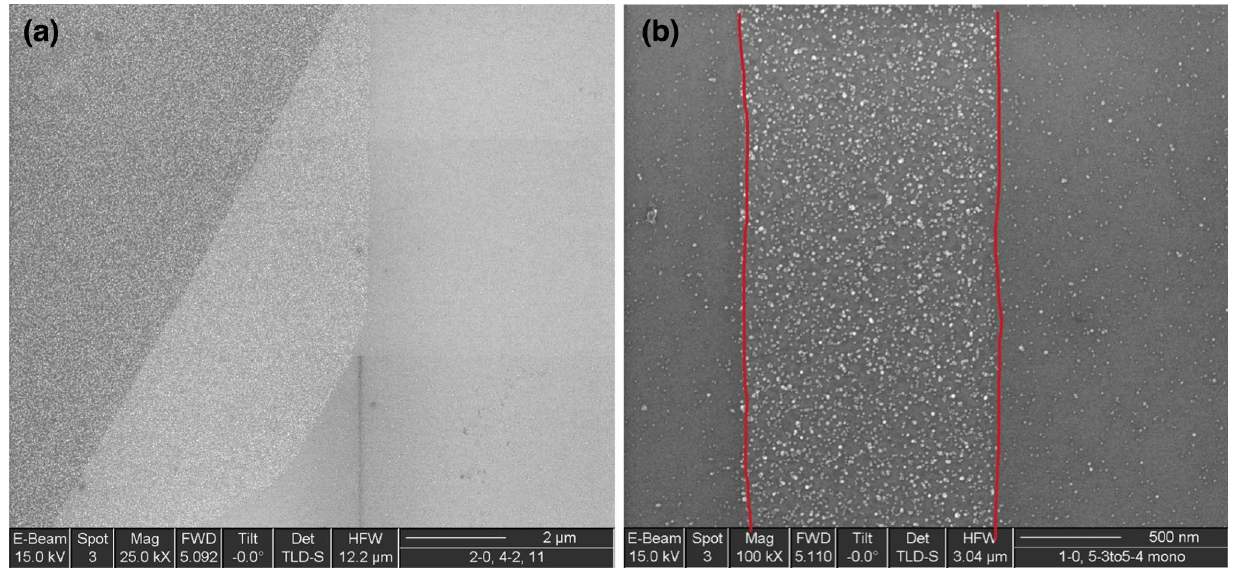
flake and bare Si surface, showing that the Ni NP assembly is much . a x denser on G. The red lines put in evidence the borders between the flake and the bare